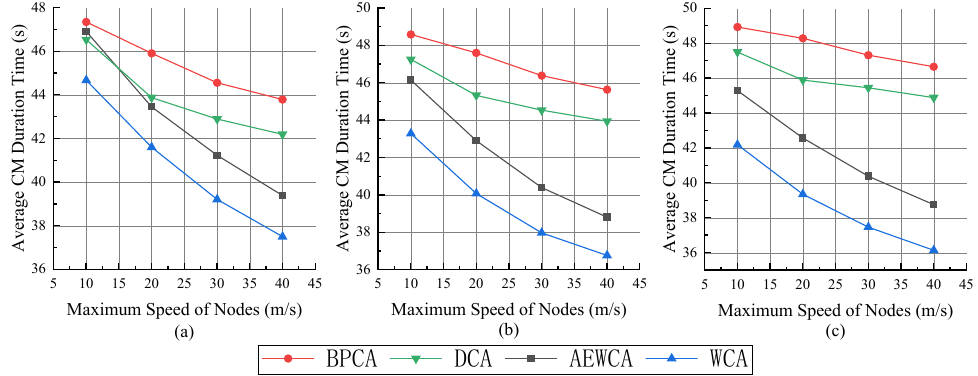
Figure 6. The effects of maximum movement speed on the average CM duration time. ( a ) Number of nodes is 100; ( b ) number of nodes is 150; ( c ) number of nodes is 200. (3) The average number of CM detached from clusters The average number of CM detached from clusters is the number of times a node breaks away from its cluster due to the dramatic movement of the CM node. The simula- tion results are shown in Figure 7.